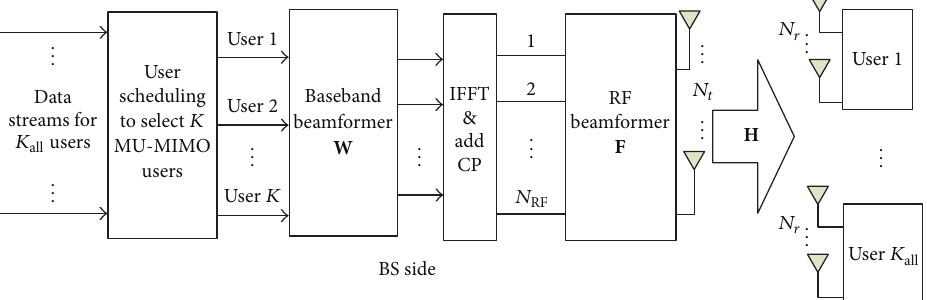
Figure 1: Block diagram of mmWave MU-MIMO system based on frequency domain user